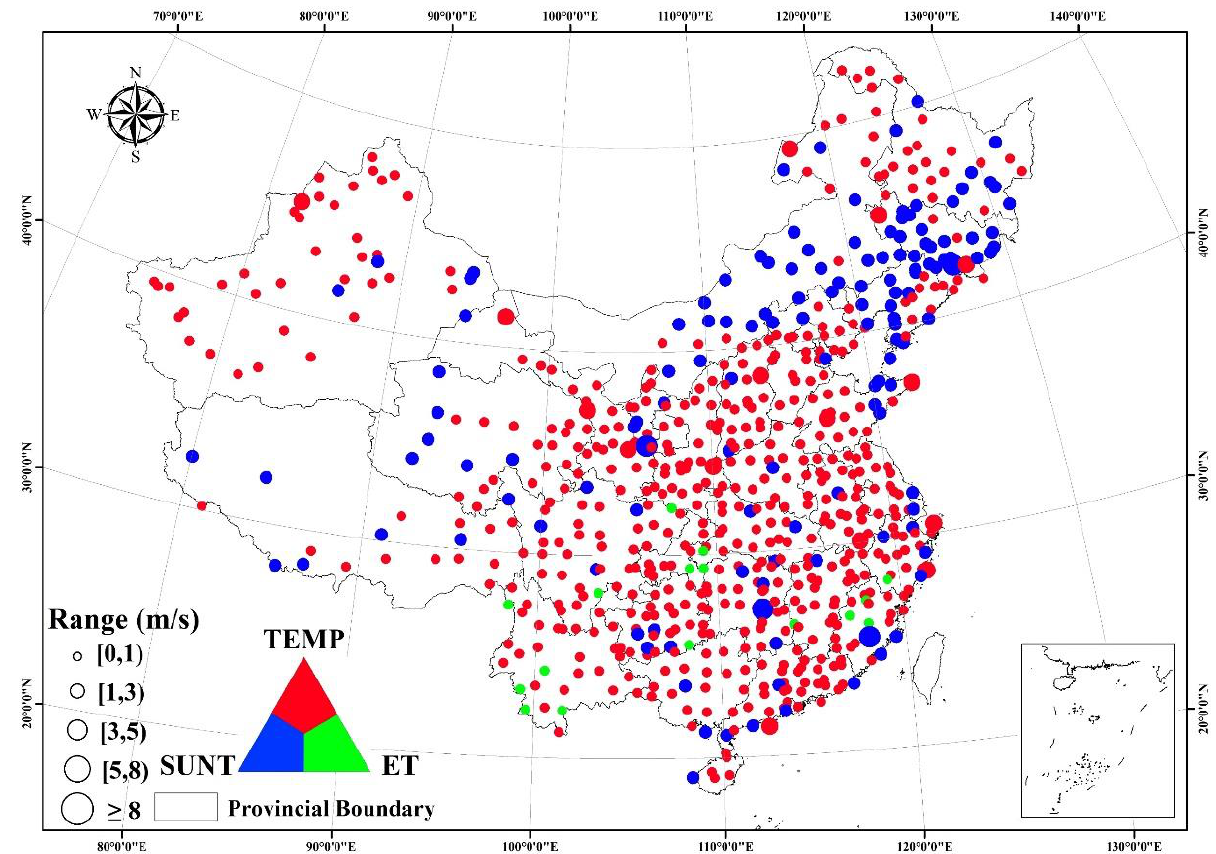
Figure 8. Triangular plot of the spatial distribution of different wind speed range correlation analysis results between wind speed and bright sunshine duration (SUNT, blue), temperature (TEMP, red), and evaporation (ET, green) in China from 2000 to 2019.